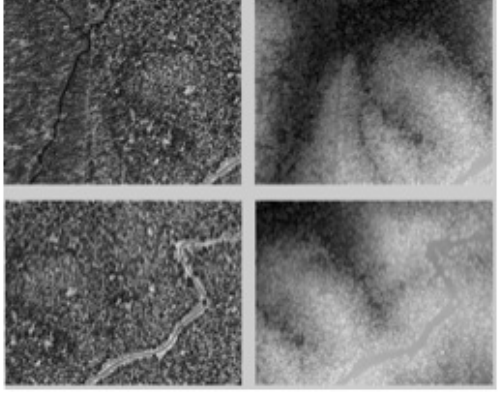
Figure 5: LiDAR intensity and elevation images